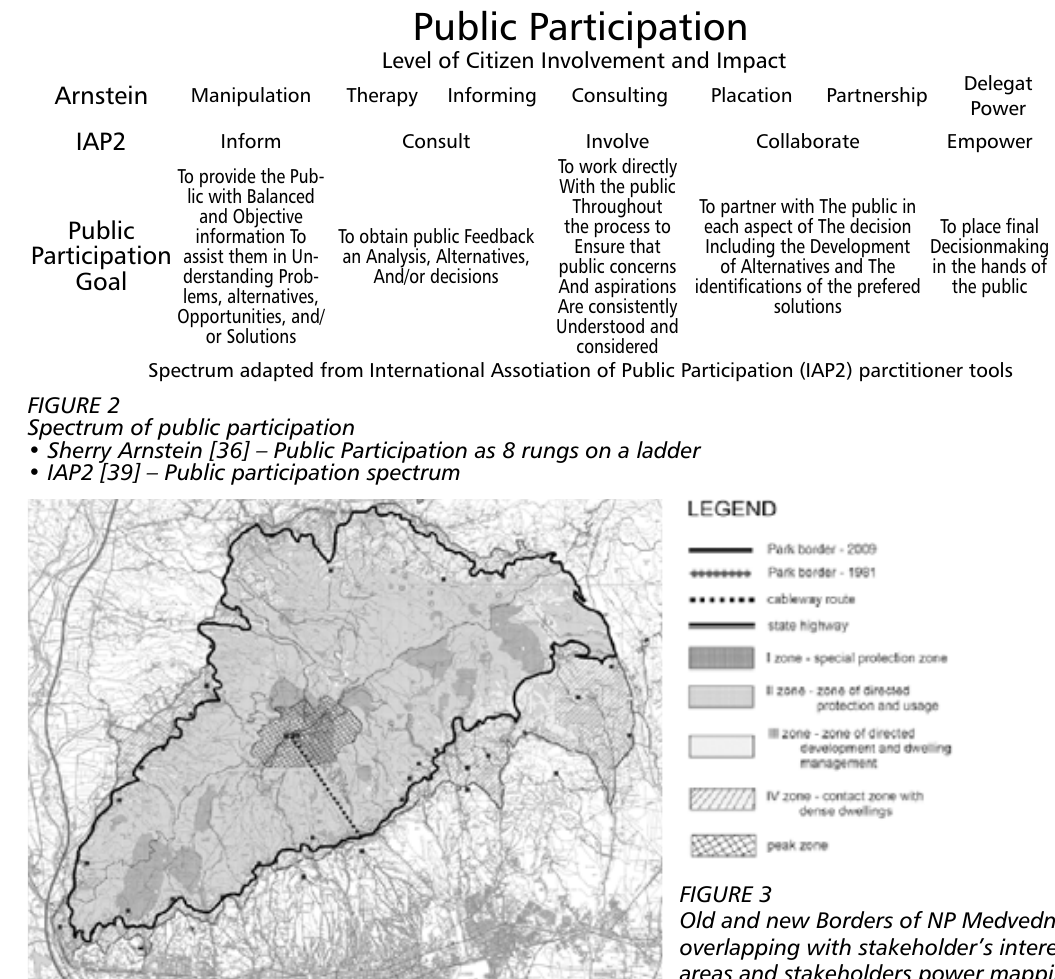
overlapping with stakeholder’s interest areas and stakeholders